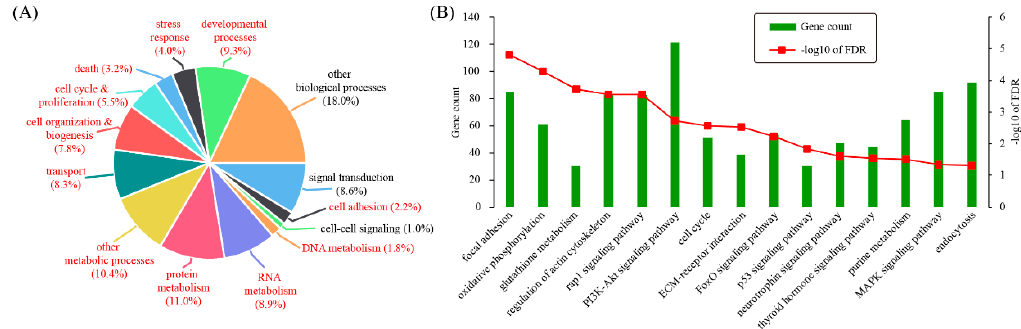
Figure 2. Gene ontology (GO) and pathway enrichment test for differentially expressed genes. ( A ) GO analysis for differentially expressed genes. Differentially expressed genes were grouped according to MGI GOslim terms within biological process categories. GO terms with p < 0.05 were colored in red. ( B ) Pathway analysis for differentially expressed genes. The enrichment analysis was carried out by using the DAVID software and the significance threshold for FDR was 0.05.